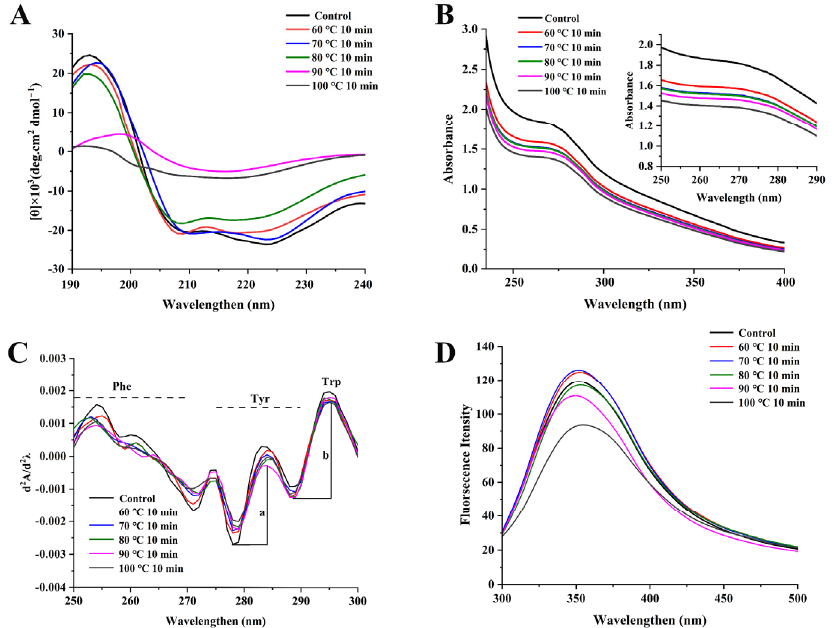
Figure 5. Effects of thermal treatment at different temperatures (untreated, 60, 70, 80, 90, and 100 ◦ C) for 10 min on the structure of ferritin. ( A ) CD spectrum, ( B ) UV absorption spectra, ( C ) second- derivative UV spectra, the letters ‘a’ and ‘b’ represent the peak-to-trough values for the two main peaks, ( D ) intrinsic fluorescence.